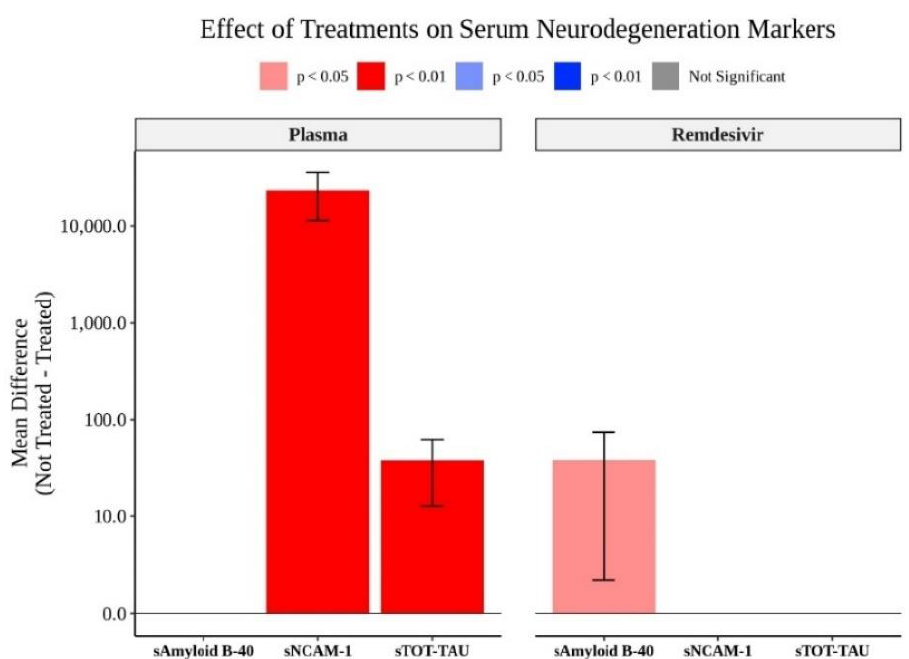
Figure 4. The effects of convalescent plasma, remdesivir were limited to total τ, amyloid β40, and NCAM-1 .